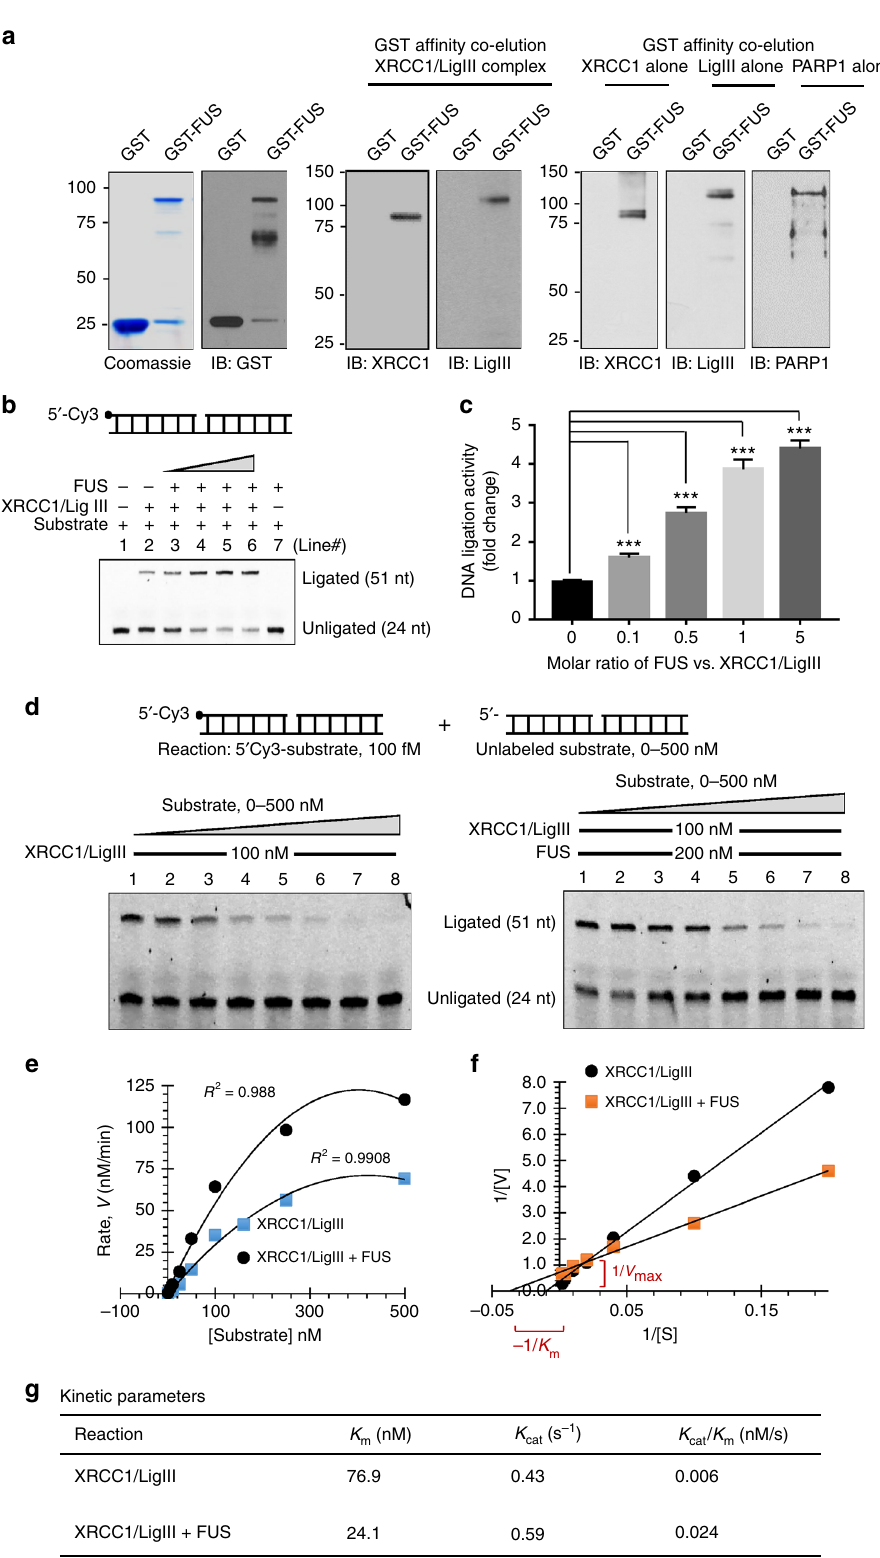
Defective DNA repair in ALS patient-derived iPSC line . Several FUS mutations, mostly familial, have been linked to ALS 1,2 . To examine the impact of FUS mutations on oxidative DNA damage repair, we cultured human fi broblast lines and iPSC lines